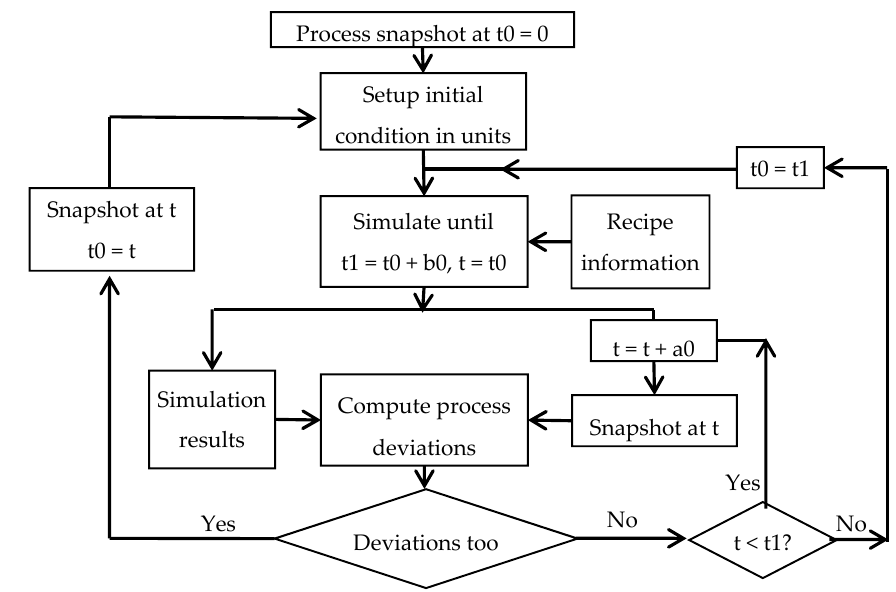
Figure 18. Steps in simulation based rescheduling.